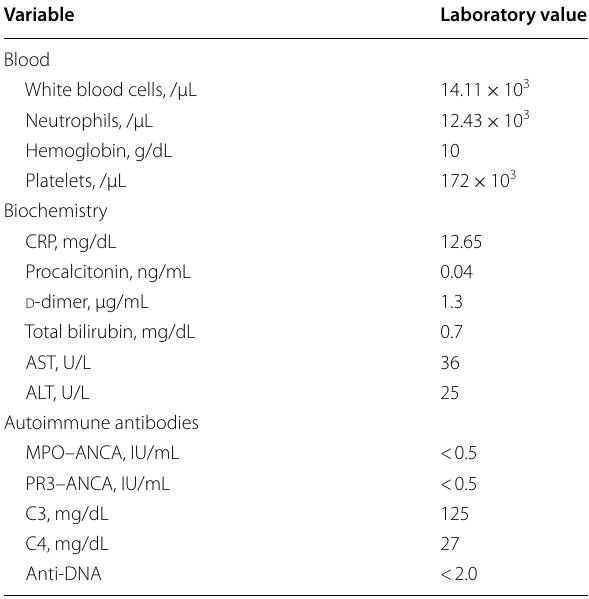
Table 1 Laboratory values on the patient’s admission to